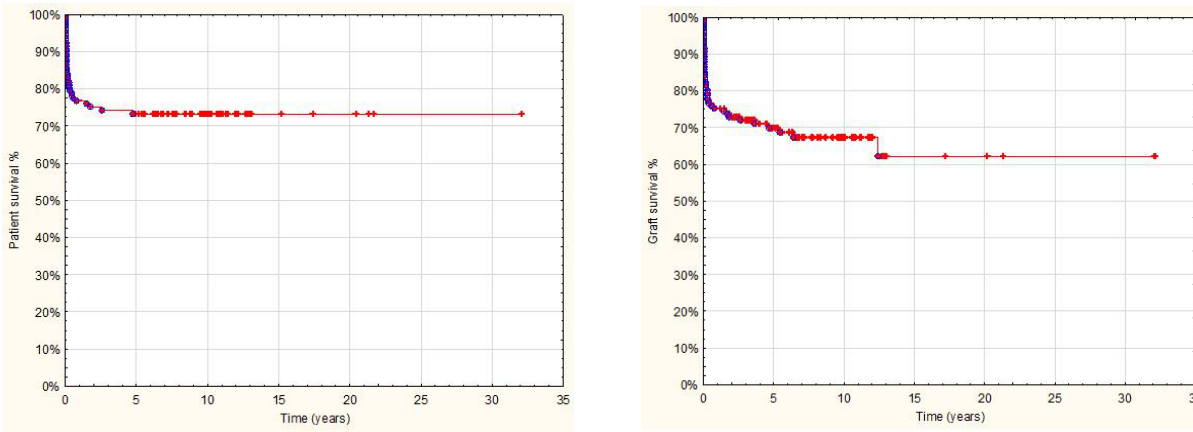
Figure 1. Overall AB0i LT patient and graft survival (142 pts after AB0i LT;